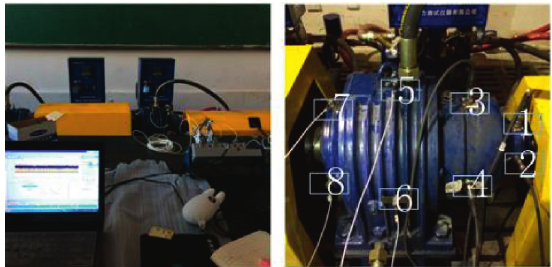
Figure 10: The scene of the vibration test and measurement point.